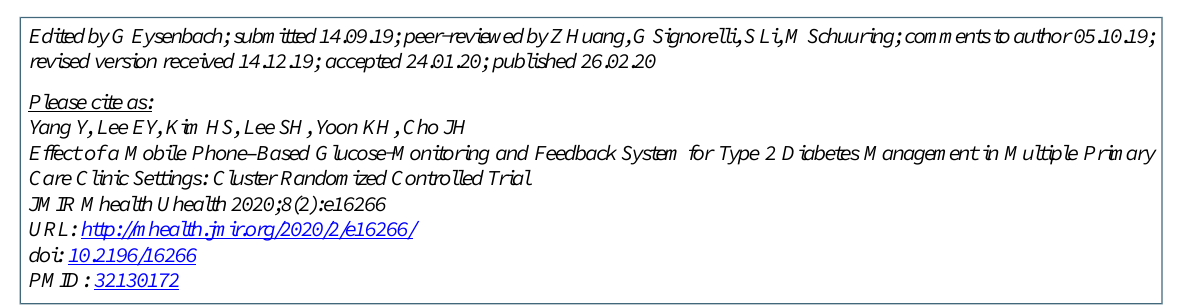
SMBG: self-monitoring of blood glucose T2DM: type 2 diabetes mellitus